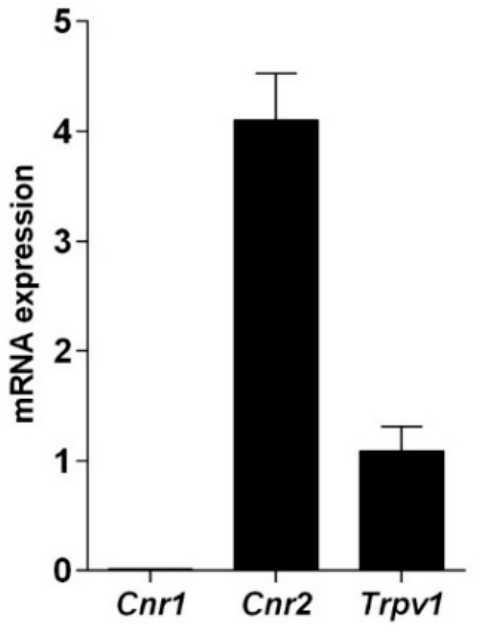
Figure 1. Quantitative RT-PCR analysis of the mRNA levels of cannabinoid and vanilloid recep- tors. The mRNA levels are expressed as fold over Trpv1 set to 1. Gene expression data are reported as 2 −ΔΔ Ct values calculated by Delta-Delta Ct method versus Trpv1 posed equal to 1.